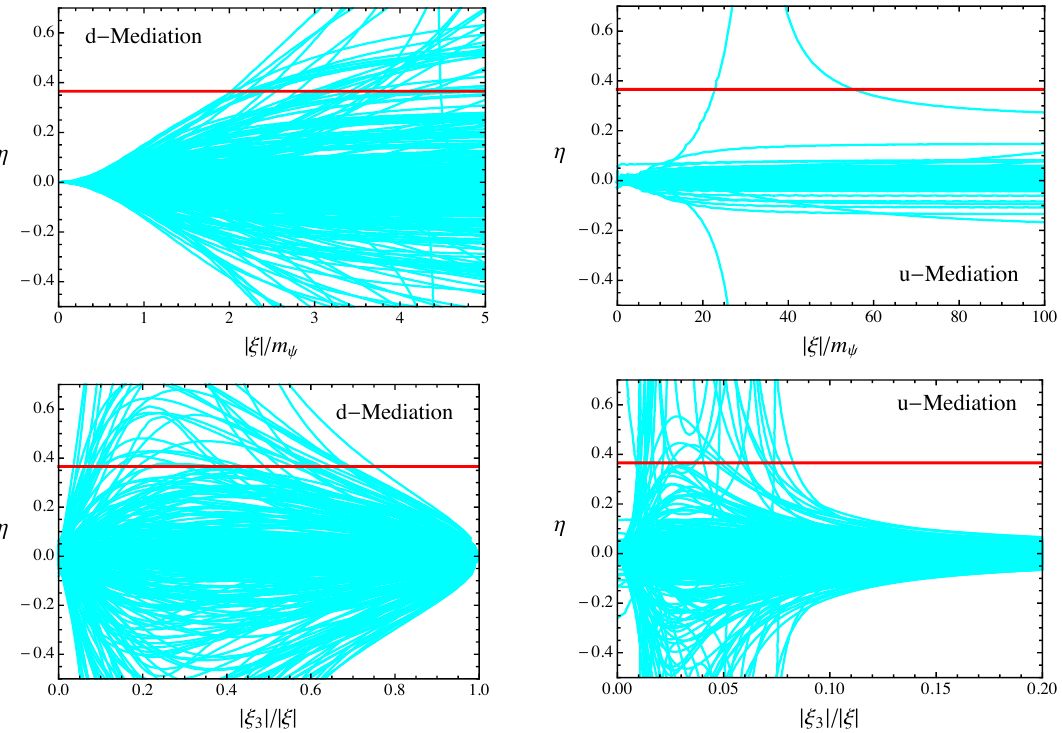
Figure 1 . Value of the CP-odd parameter η of the Wolfenstein parametrization of the CKM (recall that J = A 2 ηλ 6 [1 + O ( λ 2 )] ) in models of d -mediation (left) and u -mediation (right). In the upper C C plots we generated 300 models with random values for the direction (2 angles) and the 2 physical phases of ξ , and kept an arbitrary dependence on the modulus | ξ | /m ψ . Note the difference in the scale of the x-axis between the two plots. In the lower plots we also scanned over the modulus in the range 0 < | ξ | /m ψ < 5 ( d -mediation), 20 < | ξ | /m ψ < 40 ( u -mediation), and kept | ξ 3 | / | ξ | arbitrary. The red line indicates the real world value J ’ 3 . 0 × 10 − 5 and the cyan lines are the models’